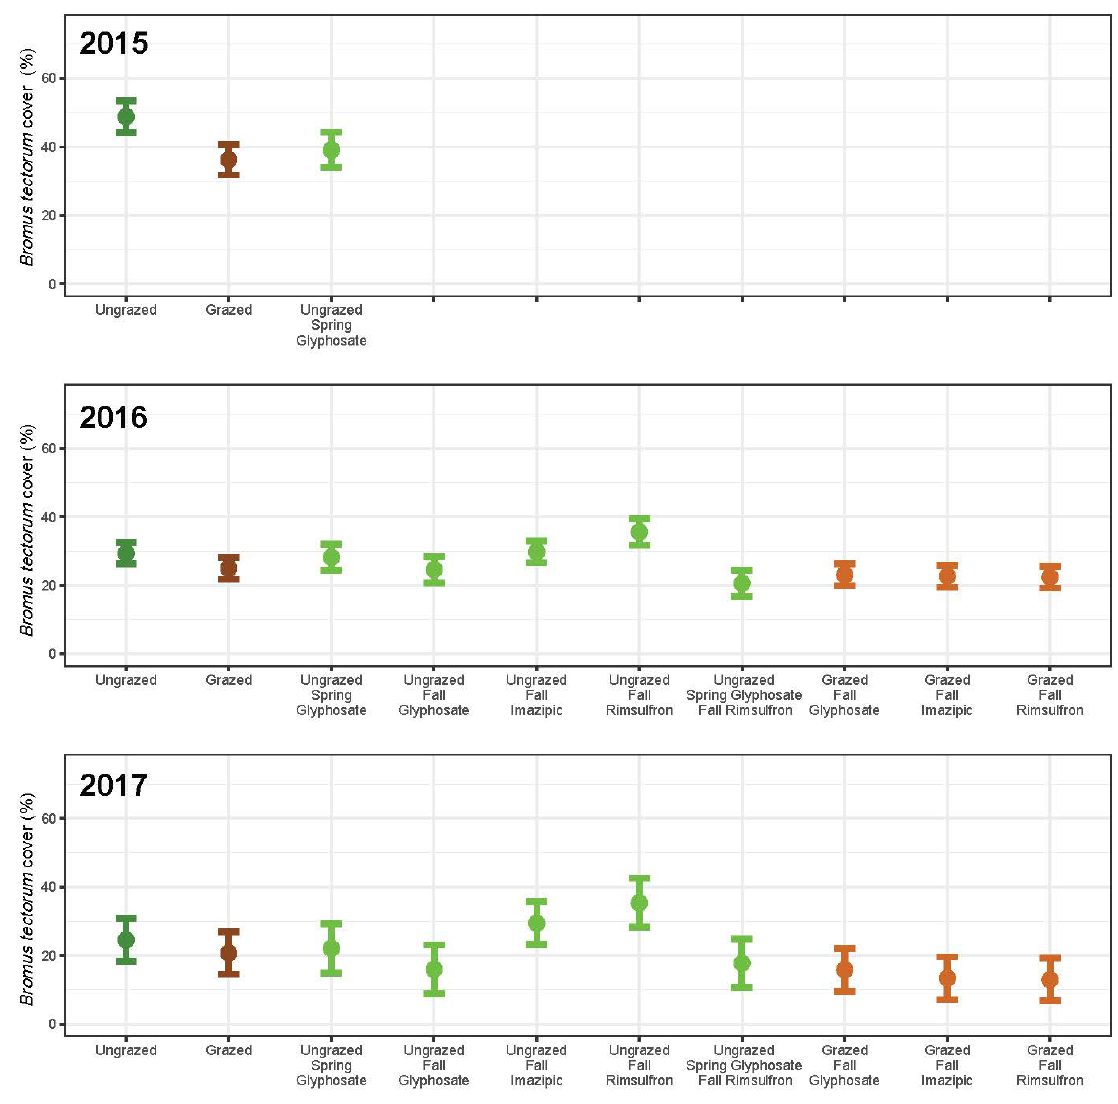
Figure 2. Fitted model results for Bromus tectorum cover (%; mean ± SE) response to grazing, herbicide and integrated treatments at Red Blu ff , Montana in 2015, 2016, and 2017. Fall herbicide treatments were implemented after summer data collection in 2015, so these treatments do not show results in 2015. Furthermore, fall herbicide results in 2016 and 2017 represent treatments implemented in the prior years. Data shown are predicted values from linear mixed e ff ects models, and thus the means are not identical to means from the raw